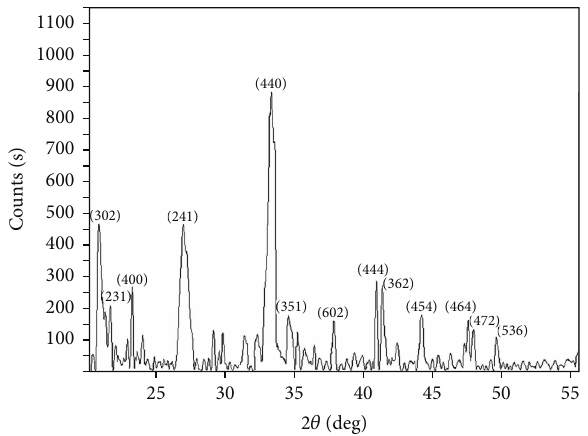
Figure 5: XRD pattern of Al 2 O 3 ⋅ CaO nanocatalyst.